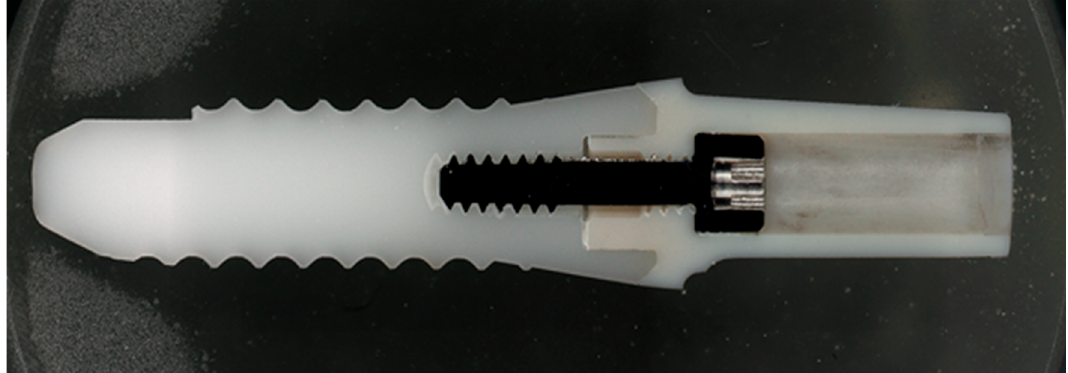
Figure 3. Exemplary cross-section of a two-piece zirconia implant.